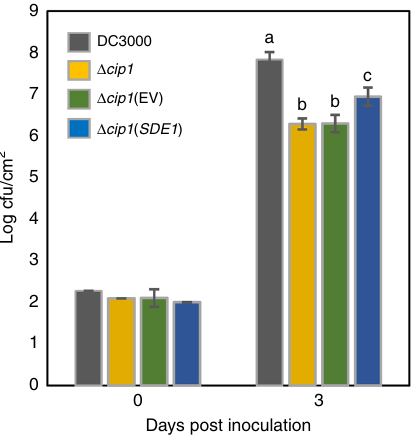
Fig. 5 SDE1 promotes Pseudomonas syringae infection of Arabidopsis . Mature leaves of 5-week-old plants of Arabidopsis thaliana ecotype Col-0 were syringe-in fi ltrated with cell suspensions of P . syringae pv. tomato ( Pto ) strains including DC3000 (wild type), Δ cip1 , Δ cip1 (empty vector, EV), and Δ cip1 ( SDE1 ). Bacterial titers were determined as colony forming units (cfu/ cm 2 ) at the time of in fi ltration (Day 0) and 3 days post in fi ltration (Day 3). Graph shows mean ± standard deviation of data from three independent experiments. Different letters (a, b, and c) indicate statistically signi fi cant differences ( p < 0.05) based on a one-way ANOVA followed by Tukey ’ s